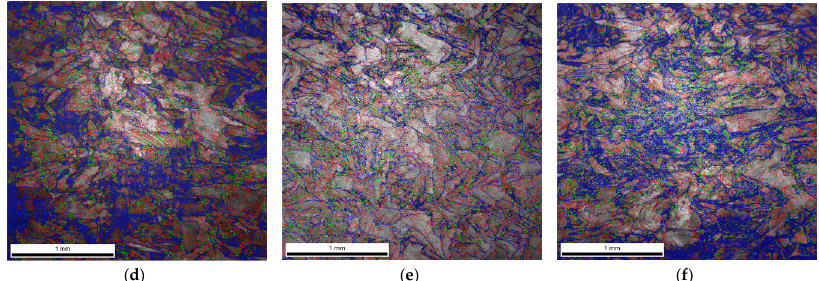
Figure 6. Image Quality (IQ) EBSD maps obtained for additively manufactured 316L steel samples subjected to dynamic plastic deformation at various rates: ( a ) not deformed; ( b ) 𝜀 (cid:4662) = 970 s − 1 ; ( c ) 𝜀 (cid:4662) =